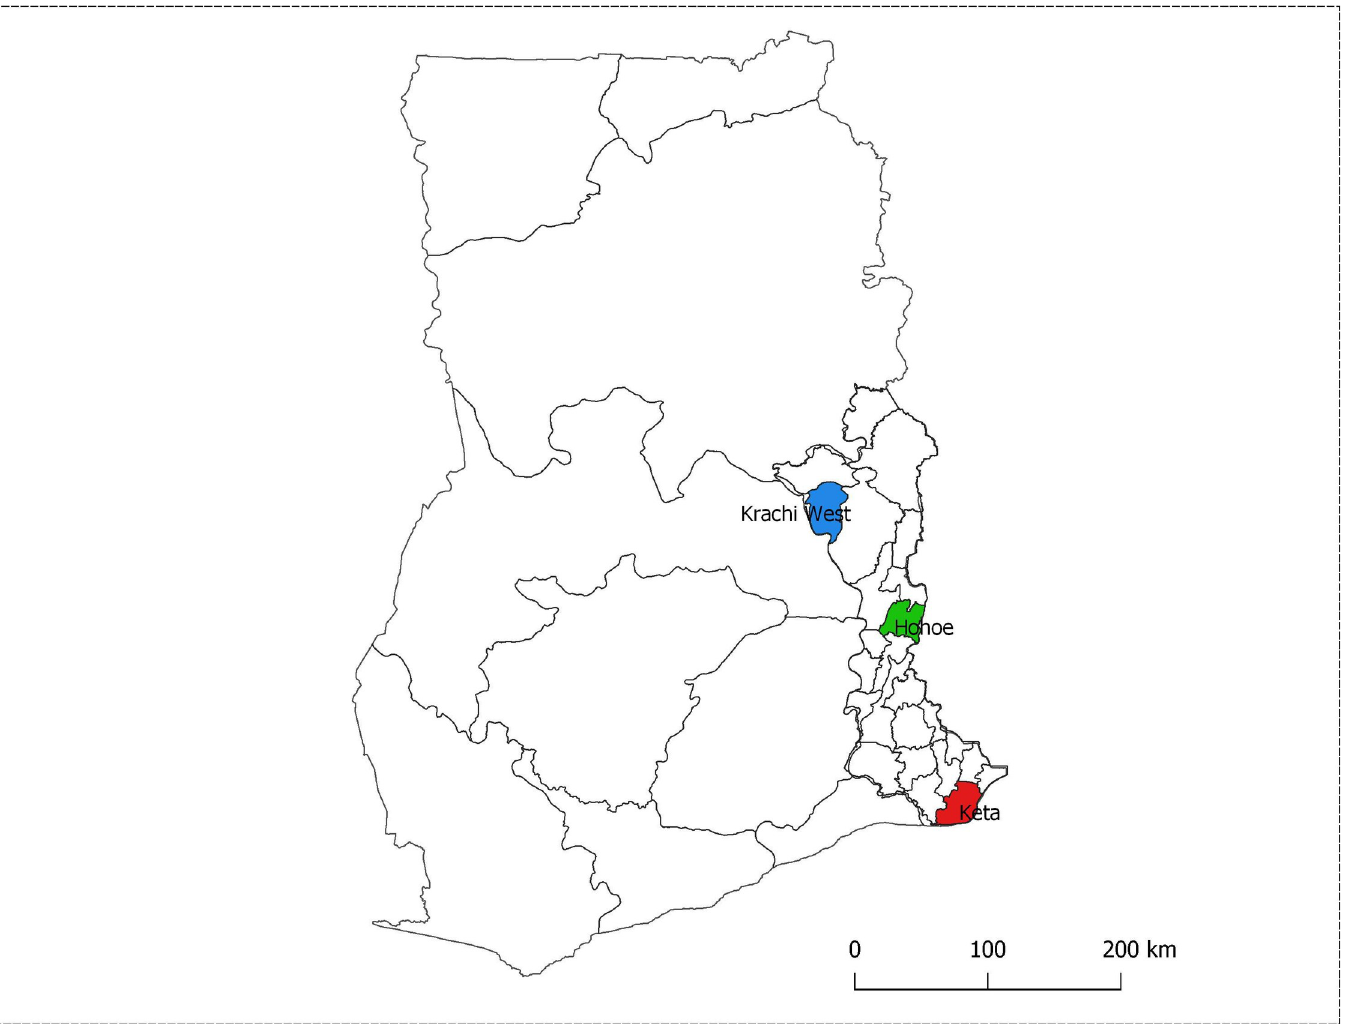
Fig 1. Map of Ghana located in West Africa showing the region and districts where sampling was done. This was the map of Ghana with the 10 regions as they existed before December 2019 when the study was performed. The red shaded area is Keta, the blue is Krachi and the green area is Hohoe. (Map was created using QGIS version 3.4.7 by Miss Jessica Asante, Department of Epidemiology, School of Public Health, University of Ghana).